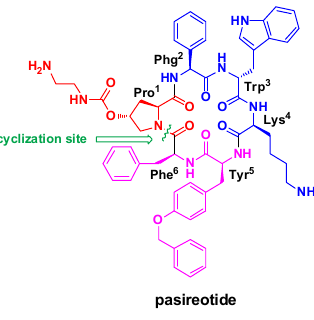
Figure 1. Structure of pasireotide.